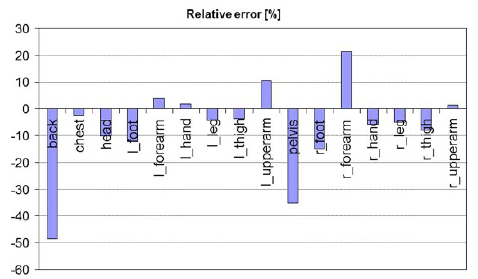
Figure 19. Relativeerror[%]betweensimulatedandmeasuredheat flux over the mannequin segments.